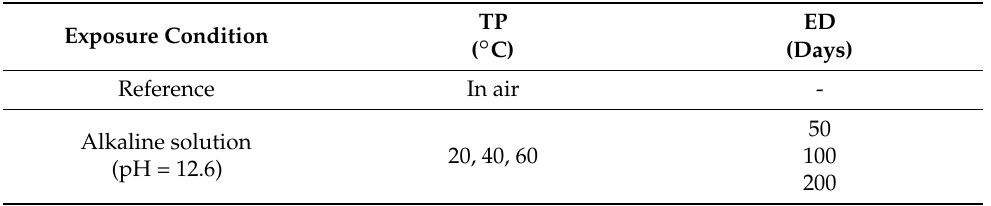
Table 1. Environmental exposure condition.